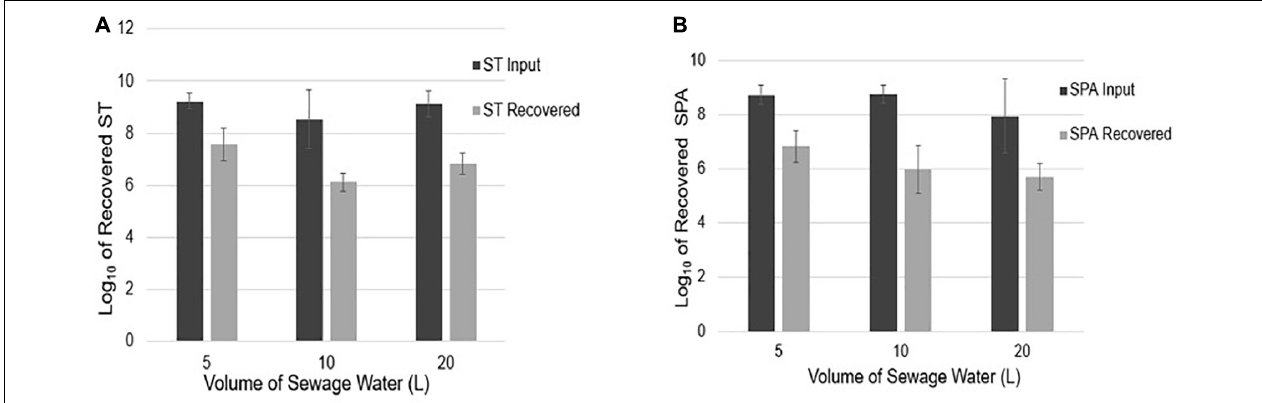
FIGURE 5 | ST and SPA mean recovery in different volumes (5, 10, and 20 L) of sewage samples using the ultrafiltration method in three replicate experiments. Error bars represent standard deviation. The experiments were validated using Salmonella strains from ATCC (ST: 19430; SPA:9150) tested by primers/probes described by Karkey et al. (2016). (A) Black bars represent the mean input ST seeded into 5, 10, and 20 L samples in three replicate experiments, and gray bars represent the mean recovered detected by qPCR. (B) Black bars represent the mean SPA seeded, and gray bars represent the mean recovered SPA detected by qPCR.